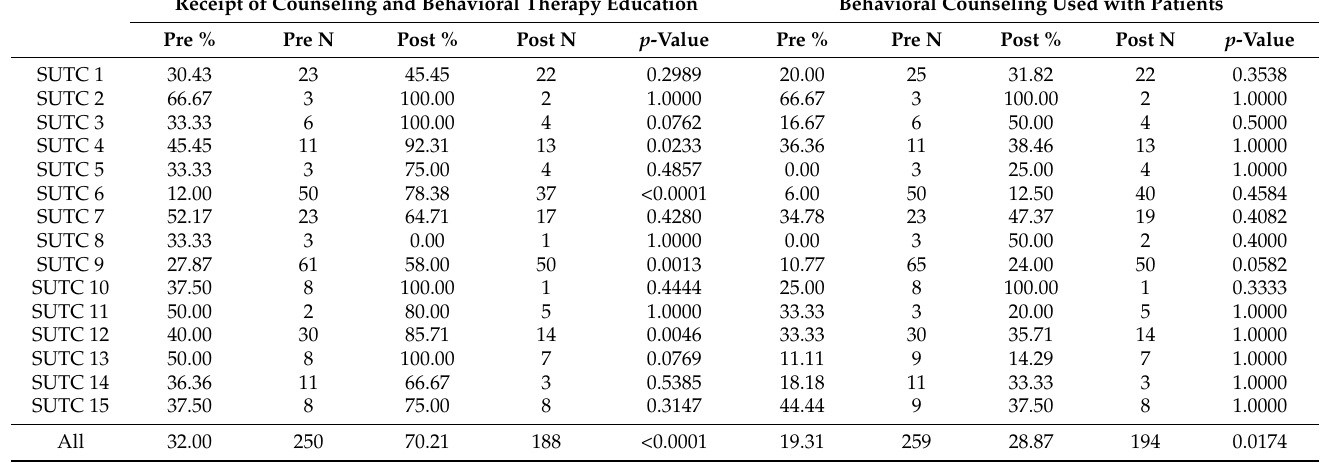
Table 2. Changes in provider-reported past-year education receipt for counseling and behavioral therapy for tobacco and the regular use of counseling and behavioral therapy with patients who use tobacco from pre- to post-implementation of a comprehensive tobacco-free workplace program that provided education on cessation counseling in 15 substance use treatment centers in Texas (pre-implementation n = 259 providers; post-implementation n = 194